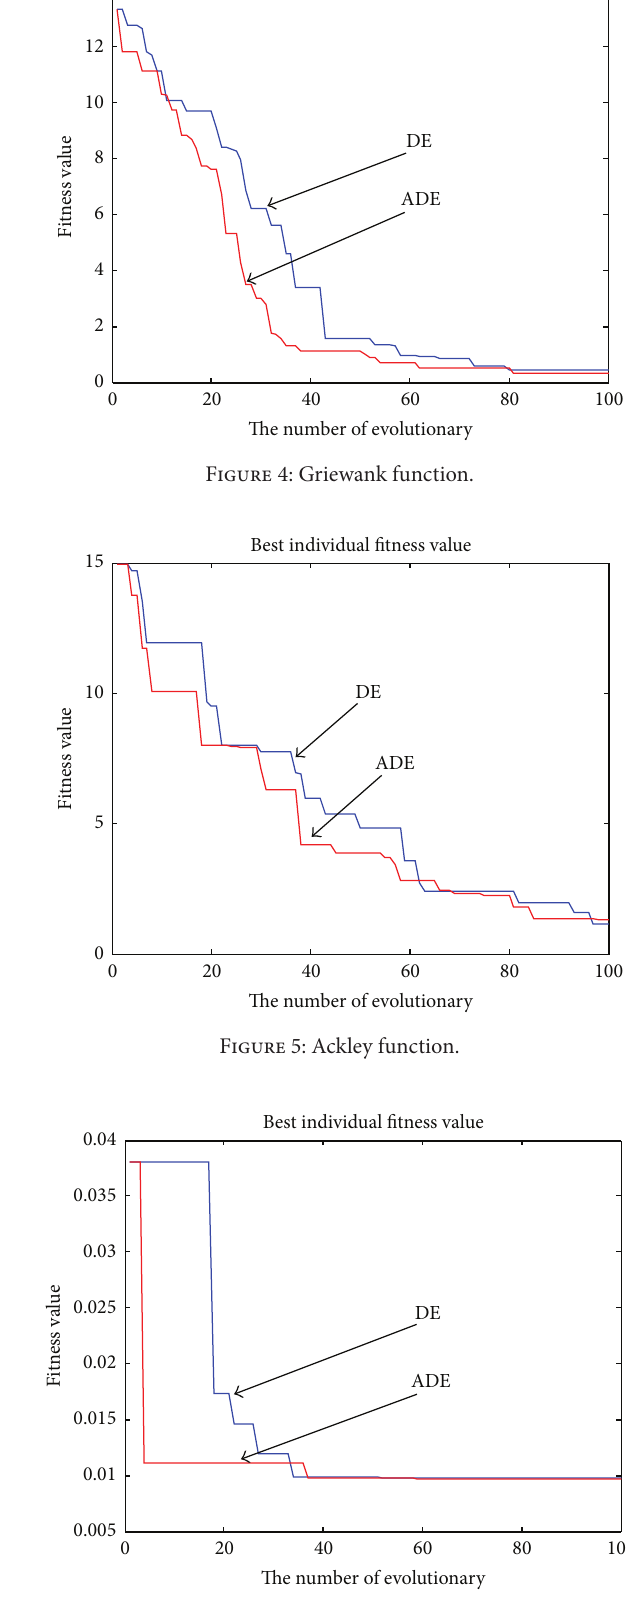
Figure 6: Shaffer’s